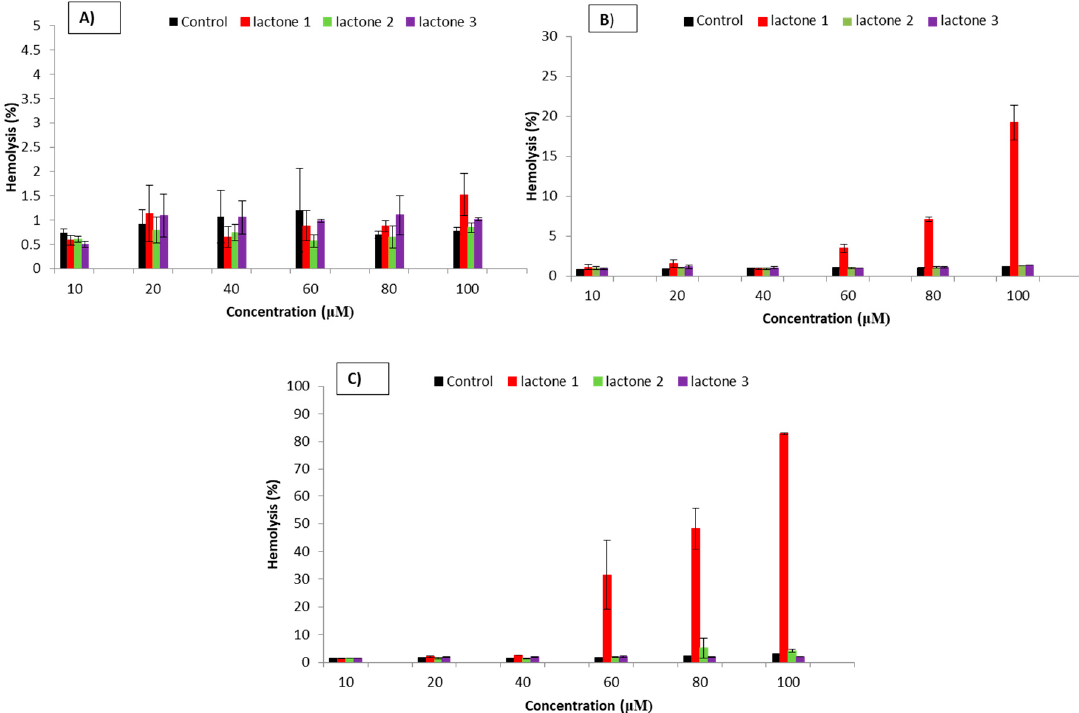
Figure 2. The dependence of hemolysis of red blood cells (RBCs) on the concentration of lactones 1 – 3 after: ( A ) 1 h, ( B ) 24 h, and ( C ) 48 h of incubation. The results are shown as mean values ± standard deviation (SD).